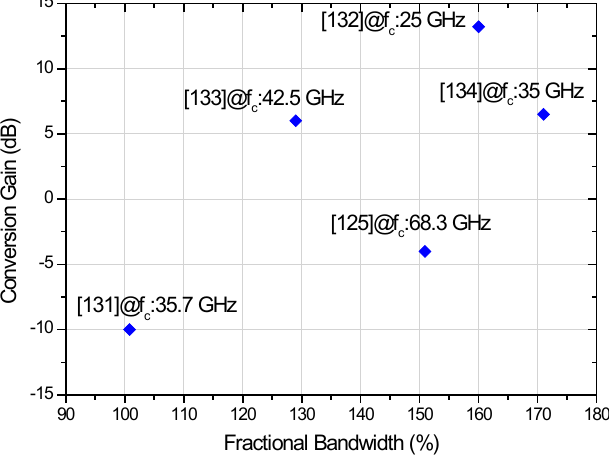
Figure 8. Common-gate (CG) versus fractional bandwidth of the recent published MMW CMOS mixers. Data taken from